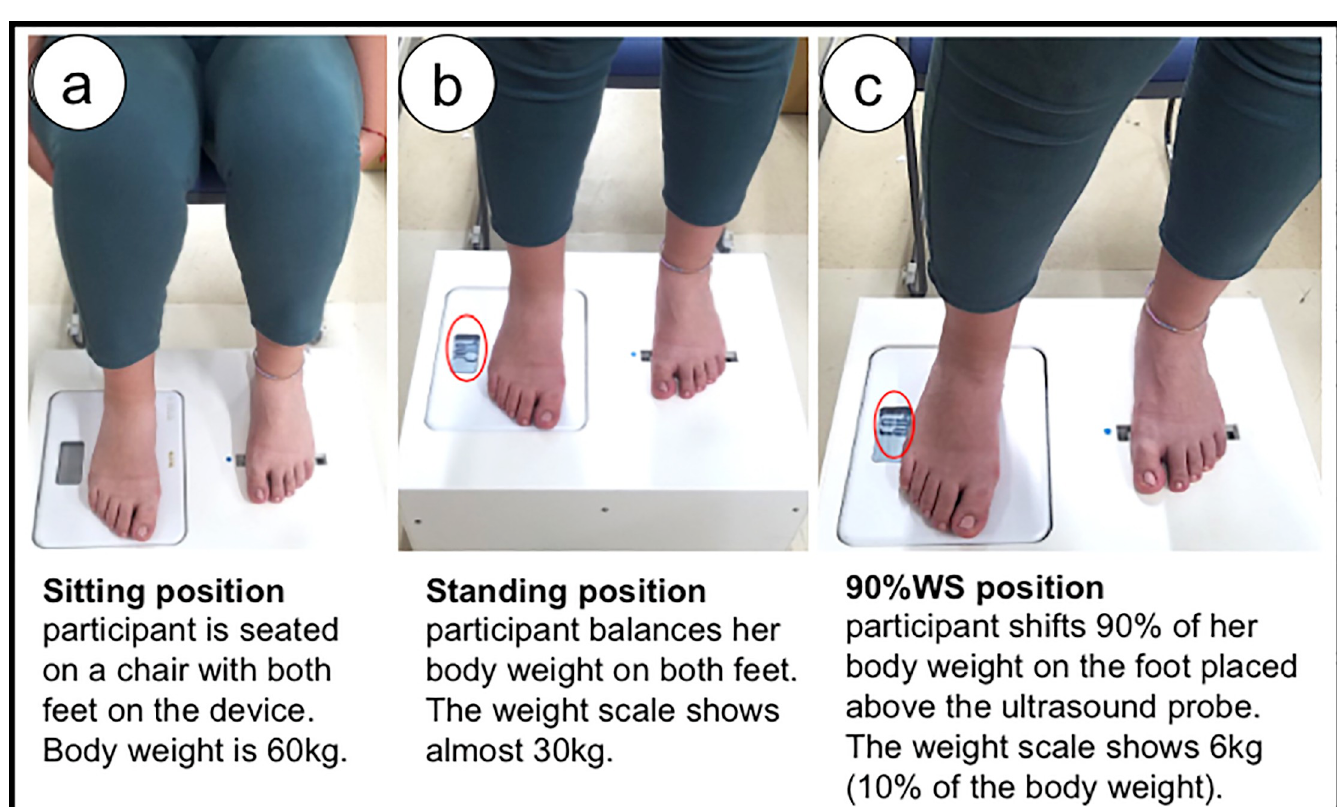
Fig 3. Measurement positions. (a) sitting position: participant is seated on a chair with knees 90 degrees flexed, both feet placed for measurement; (b) standing position: participant keeps her feet as placed in the former position and stands up. The weight scale is used to balance half the weight on both feet; (c) 90%WS position: 90% of body weight is placed on the tested foot while 10% of the body weight is monitored on the weight scale under the nontested foot. 90%WS: 90% weight